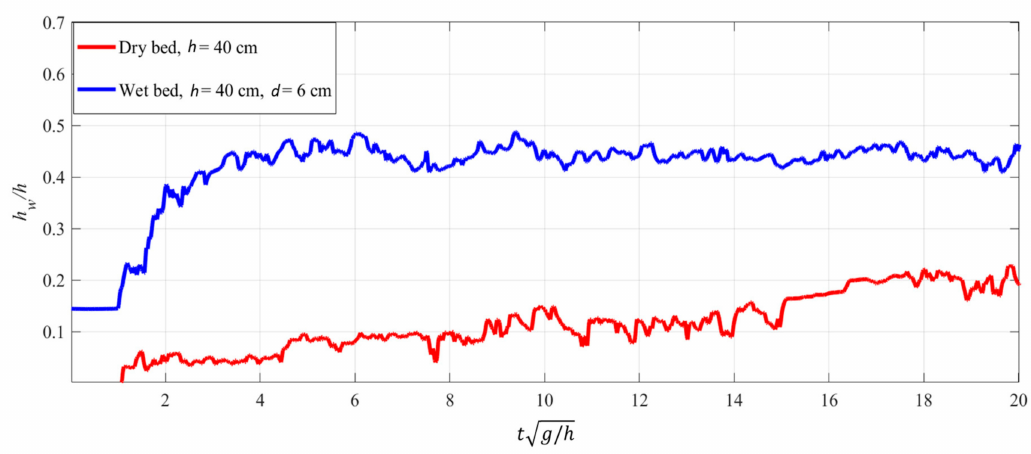
Figure 10. Comparison between dry bed and wet bed condition normalized water depth time-history.